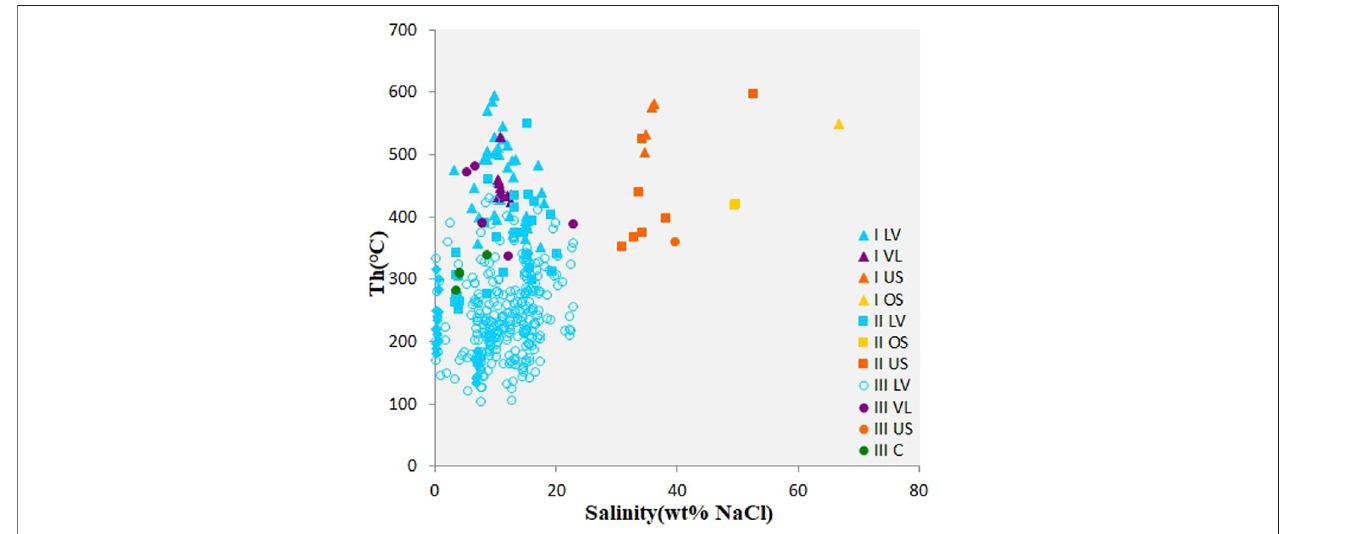
FIGURE 6 | Homogenization temperature vs salinity of the Gejiu Sn – Cu polymetallic deposit. The high – salinity fl uid was mainly concentrated in unsaturated daughter crystal inclusions (type US) in stages I and II.